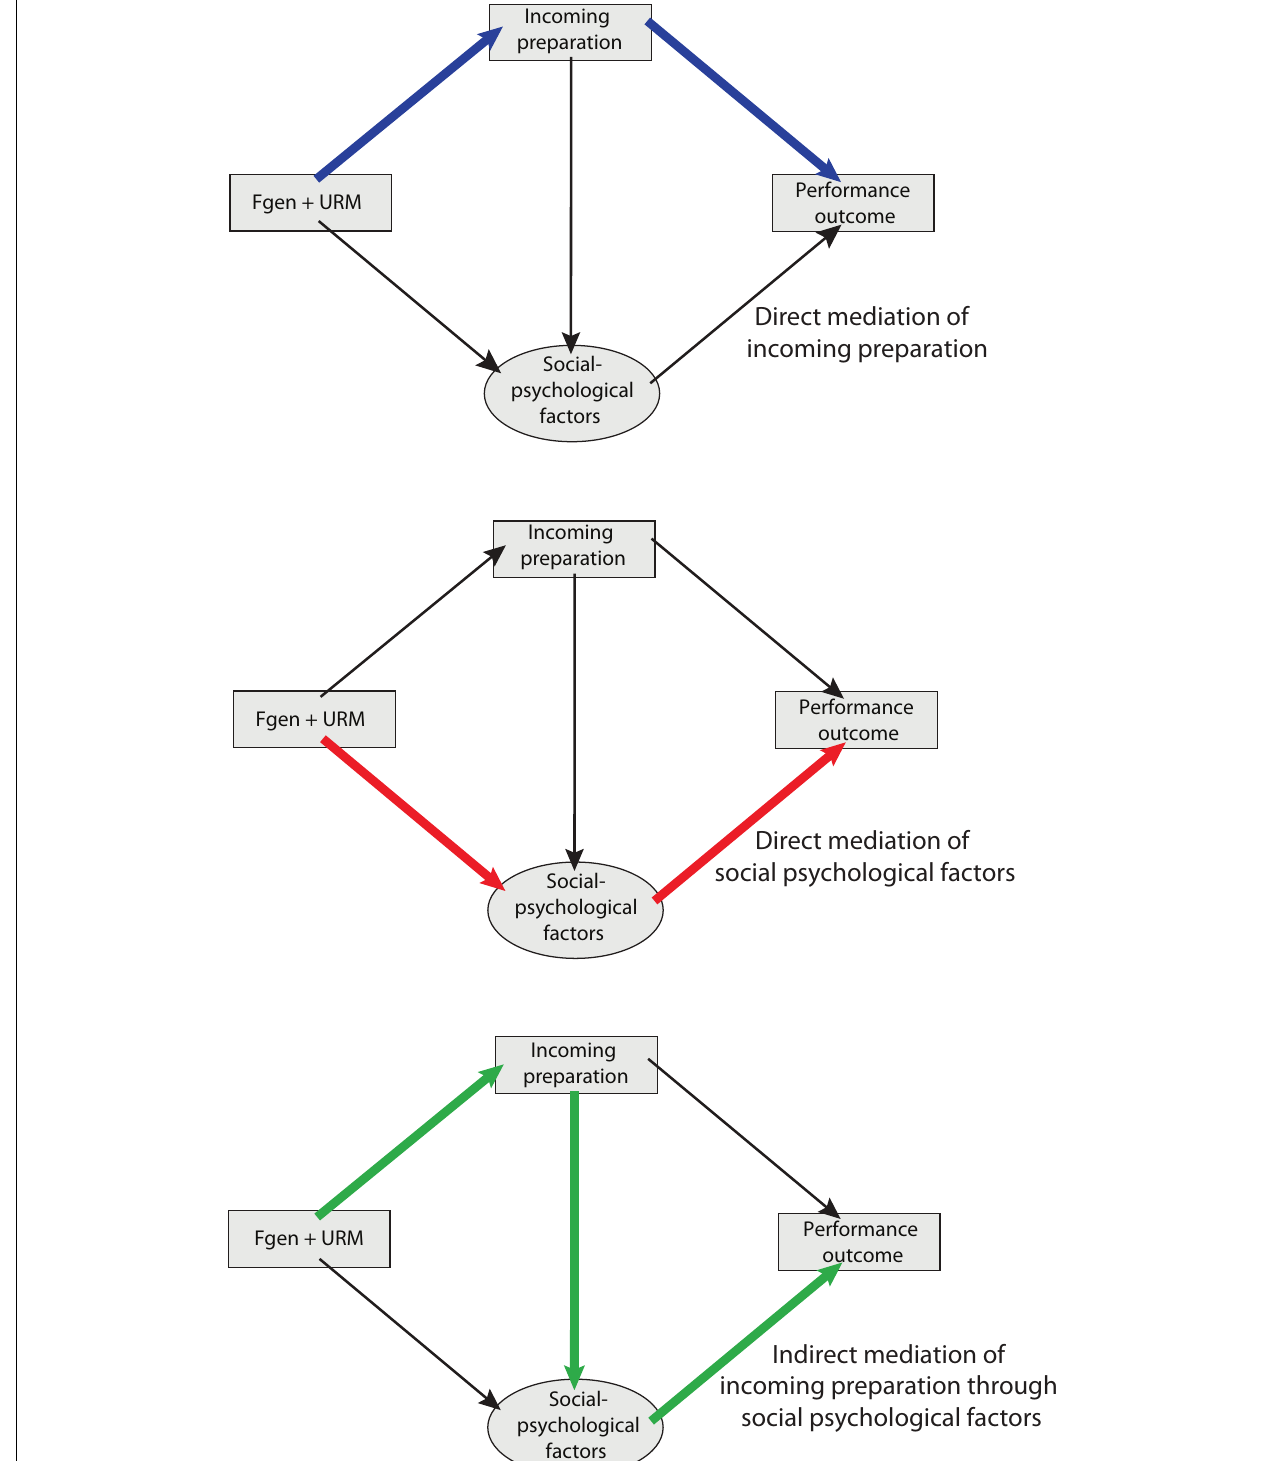
FIGURE 2 | A full mediation model predicting student performance in introductory STEM courses. The relationship between demographic status (first-generation status, or Fgen, and underrepresented minority status, or URM) and academic outcomes can be explained through three mediation paths: 1) direct mediation of incoming preparation ( top , blue arrows) 2) direct mediation of social psychological factors ( middle , red arrows) and 3) indirect mediation of incoming preparation through social psychological factors ( bottom , green arrows).